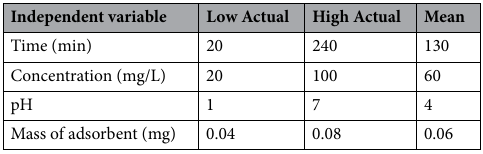
Table 1. Experimental range of independent